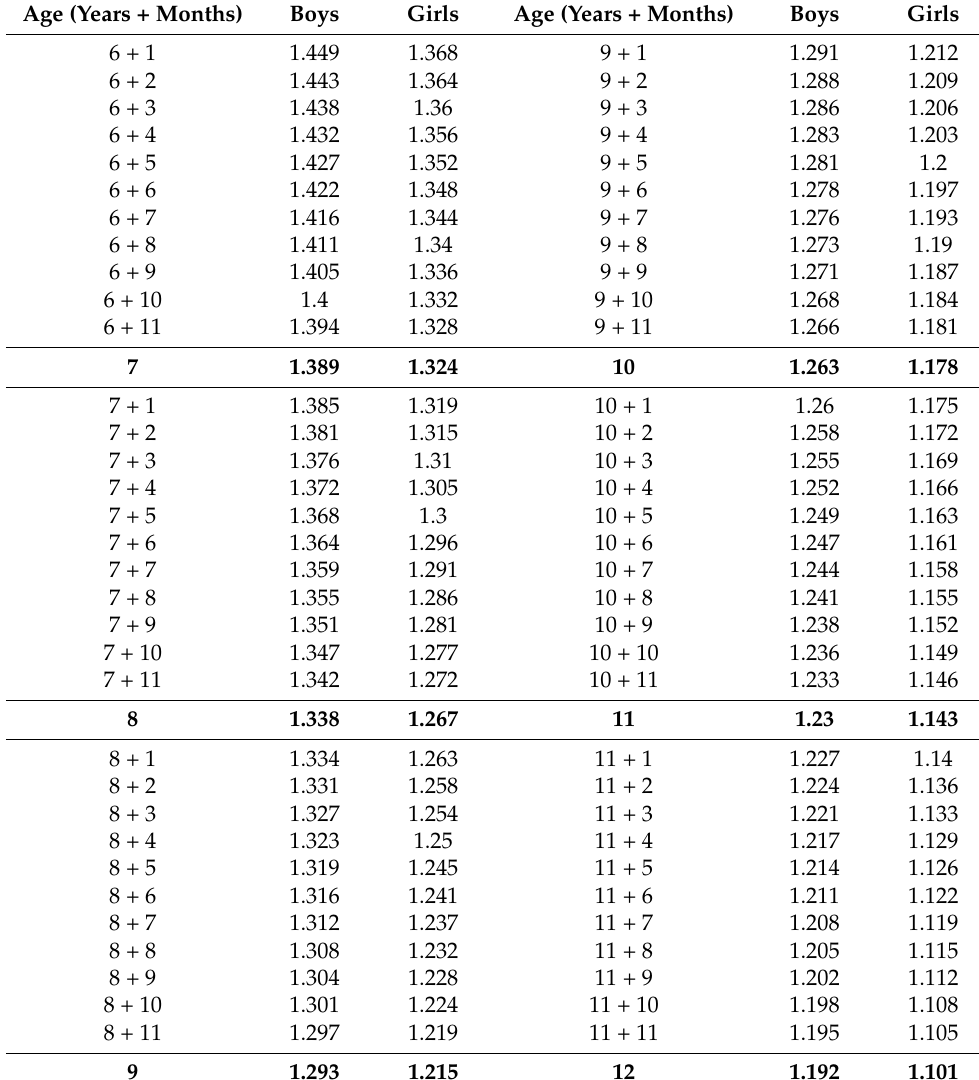
Table 2. Sitting height multiplier for 6+ to 9 years of age.